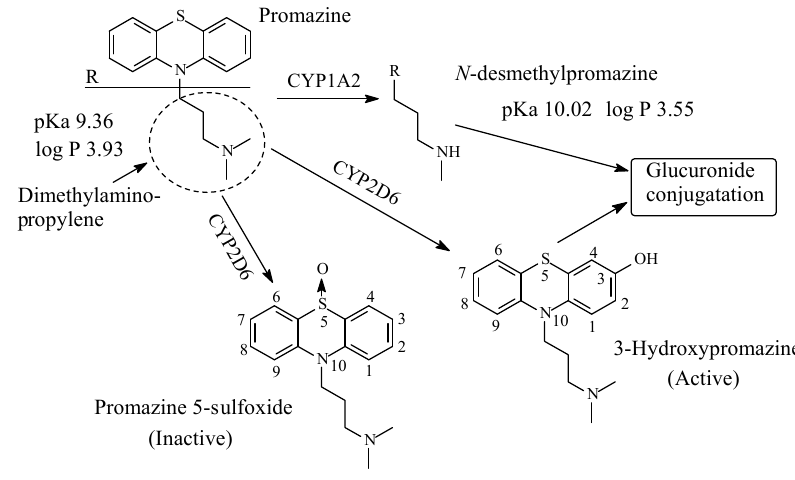
Figure 21. Metabolic pathways of promazine.